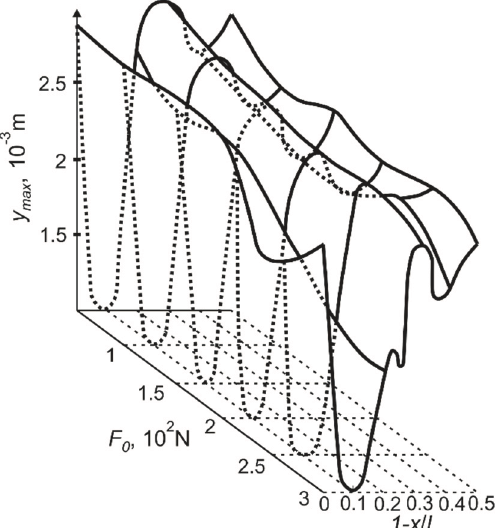
Figure 11. Dependence of the cantilever rebound amplitude y max on the position of the support 1- x / l (distance of the support from the free end of the cantilever) and the pre–stress of the cantilever F 0 on the support.